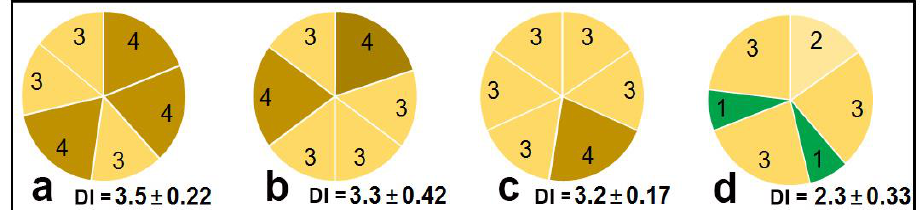
Figure 5. Diagrams illustrating results of the tomato leaf disk assay that included inoculations of disks with A. solani conidial suspensions in ( a ) water; ( b ) Folicur ® (0.05 µ g / mL); ( c ) WAMP-G1 (200 µ g / mL); and ( d ) mixture containing this fungicide and WAMP-G1 at the same concentrations as in ( b , c ). Numbers in the diagram sectors indicate scores for each of six leaf discs assayed. DI is average scoring of the damage (mean ± SE).